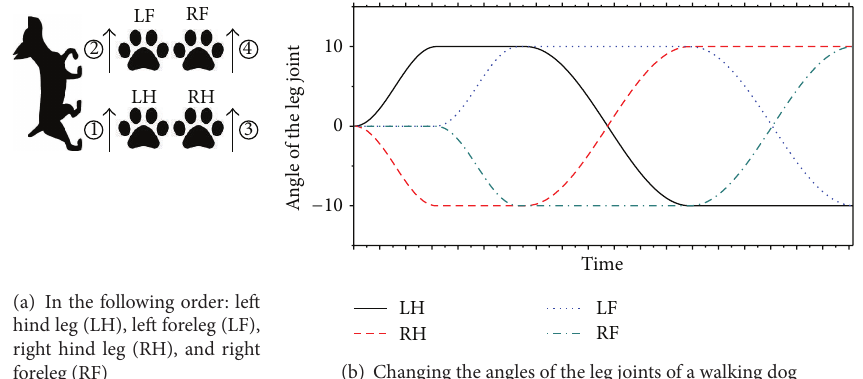
Figure 3: Dog walking sequence.